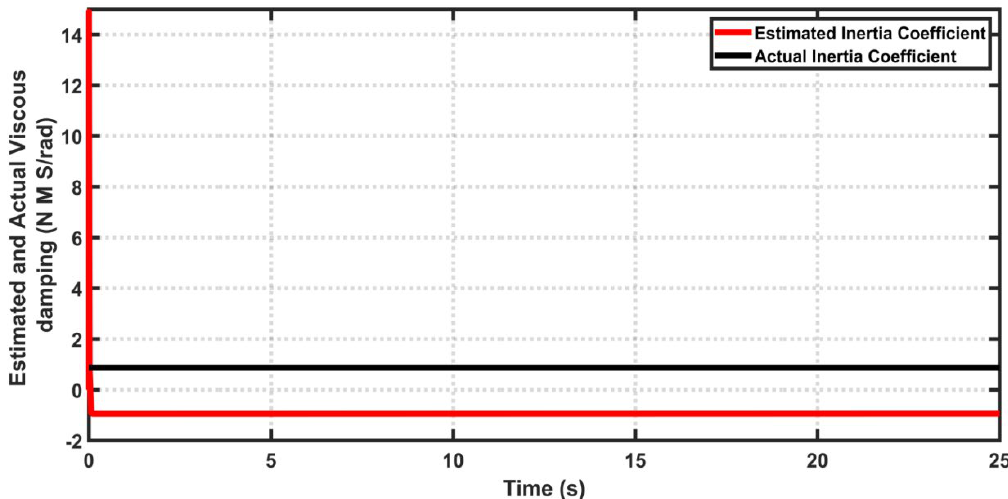
Figure 13. Behaviors of actual and estimated viscous damping coefficients f v .